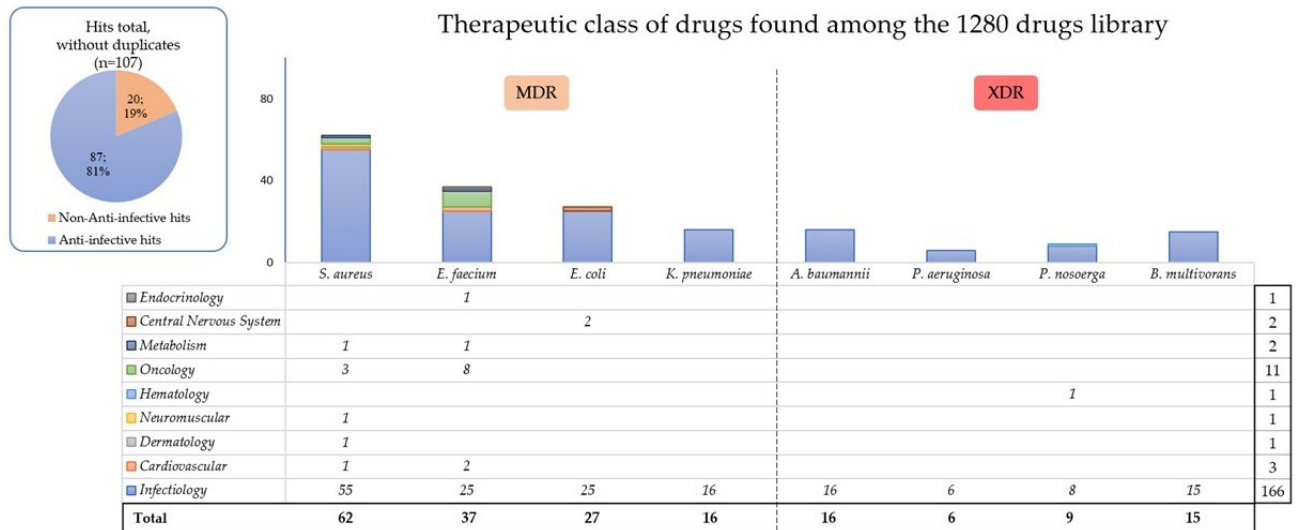
Figure 1. Hits found after an in vitro screening of the 1280 drugs library for each bacterium according to their therapeutic class. On the left, we discarded the duplicates and found 107 hits for all the Gram positive and negative bacteria. Some drugs are classified in various therapeutic classes and can be either antibacterial, antifungal, or antiviral, so we first considered the antibacterial effect in our counting or the major known effect. This chart highlights that most molecules that are active in vitro against bacterial growth are anti-infectives. Only a few options among the 1280 molecules tested can inhibit the bacterial growth of P. nosoerga or P. aeruginosa . All the compounds per bacterium are detailed in Supplementary Table S1. MDR: multidrug-resistant; XDR: extensively drug-resistant.